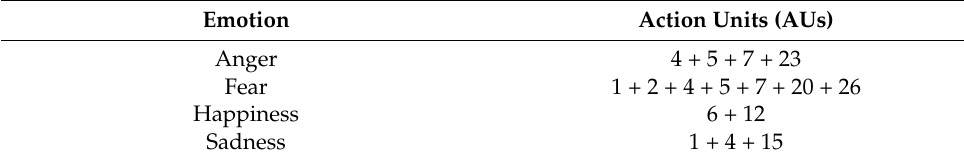
Table 2. List of expressions considered in the facial expression categorization test and relative FACS action units [40].